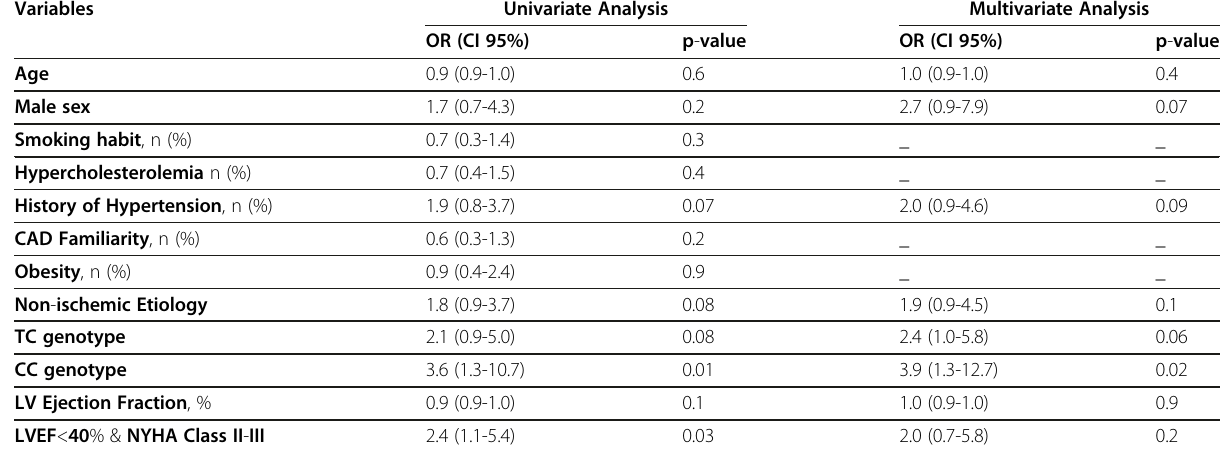
Table 2 Predictors of HOMA-IR at univariate and multivariate analysis by logistic regression Variables